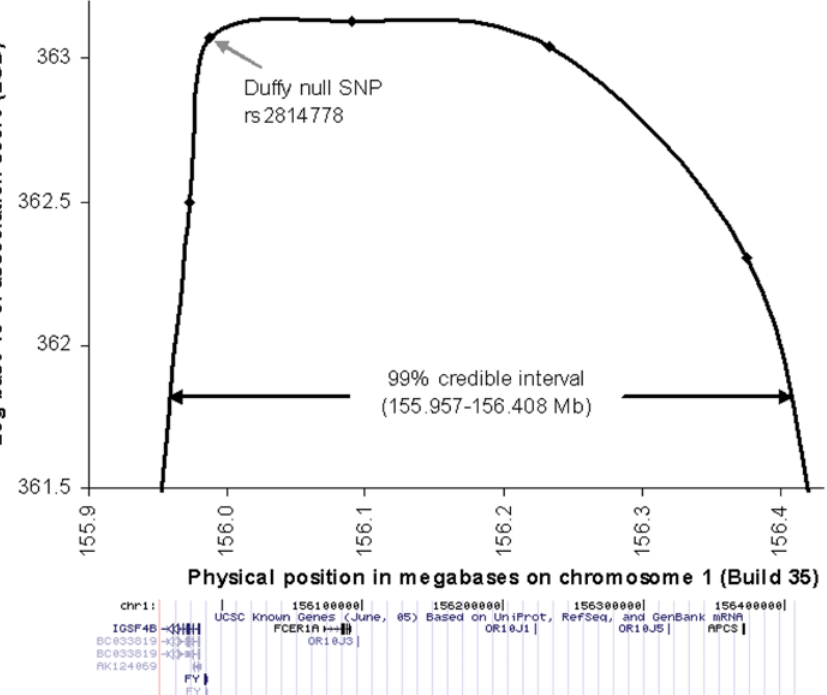
Figure 2. Admixture association defines a 451 kb region containing the risk allele. The LOD score for admixture association to neutrophil count shows a peak of 363.1, and a 99% confidence interval of 155.957–156.408 Mb (the region where the LOD score is within 1.44 of its maximum). The known genes under the peak are obtained using a screenshot of the ‘‘Known Genes’’ track from the UCSC genome browser (http://genome.ucsc.edu).